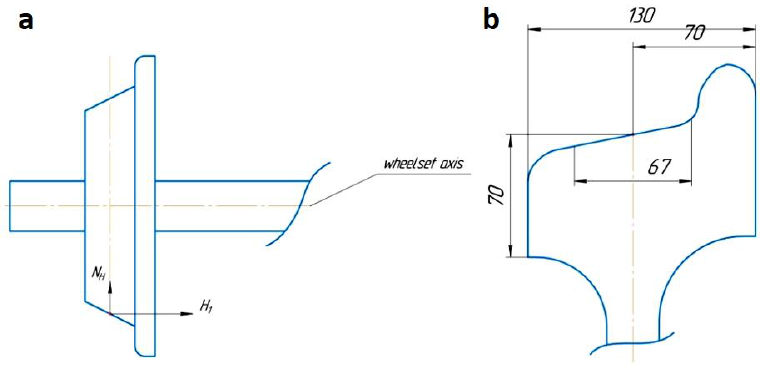
Figure 11. Wheel design shown in the design diagram: ( a ) standard car wheel; ( b ) simplified dia-